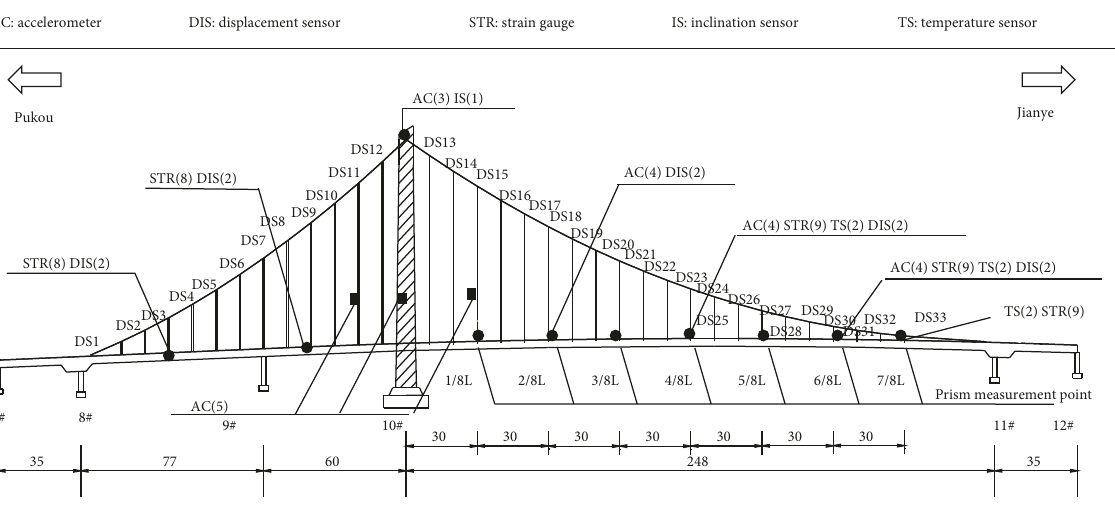
Figure 3: SHM system of the bridge.